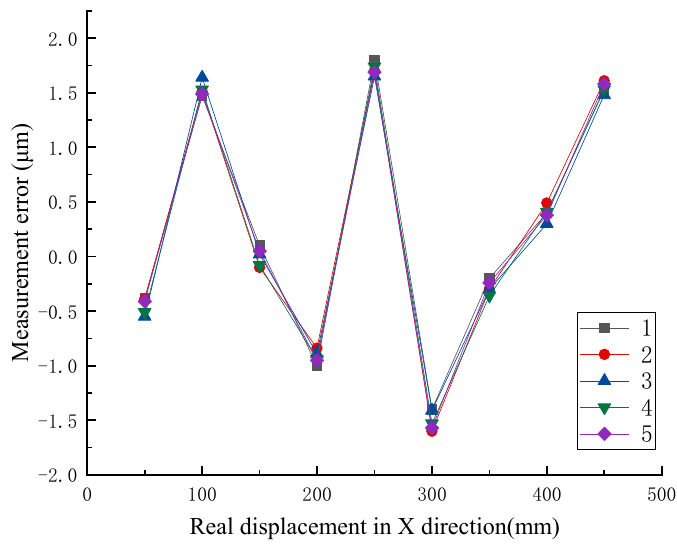
Figure 15. Measurement errors in the direction of X.